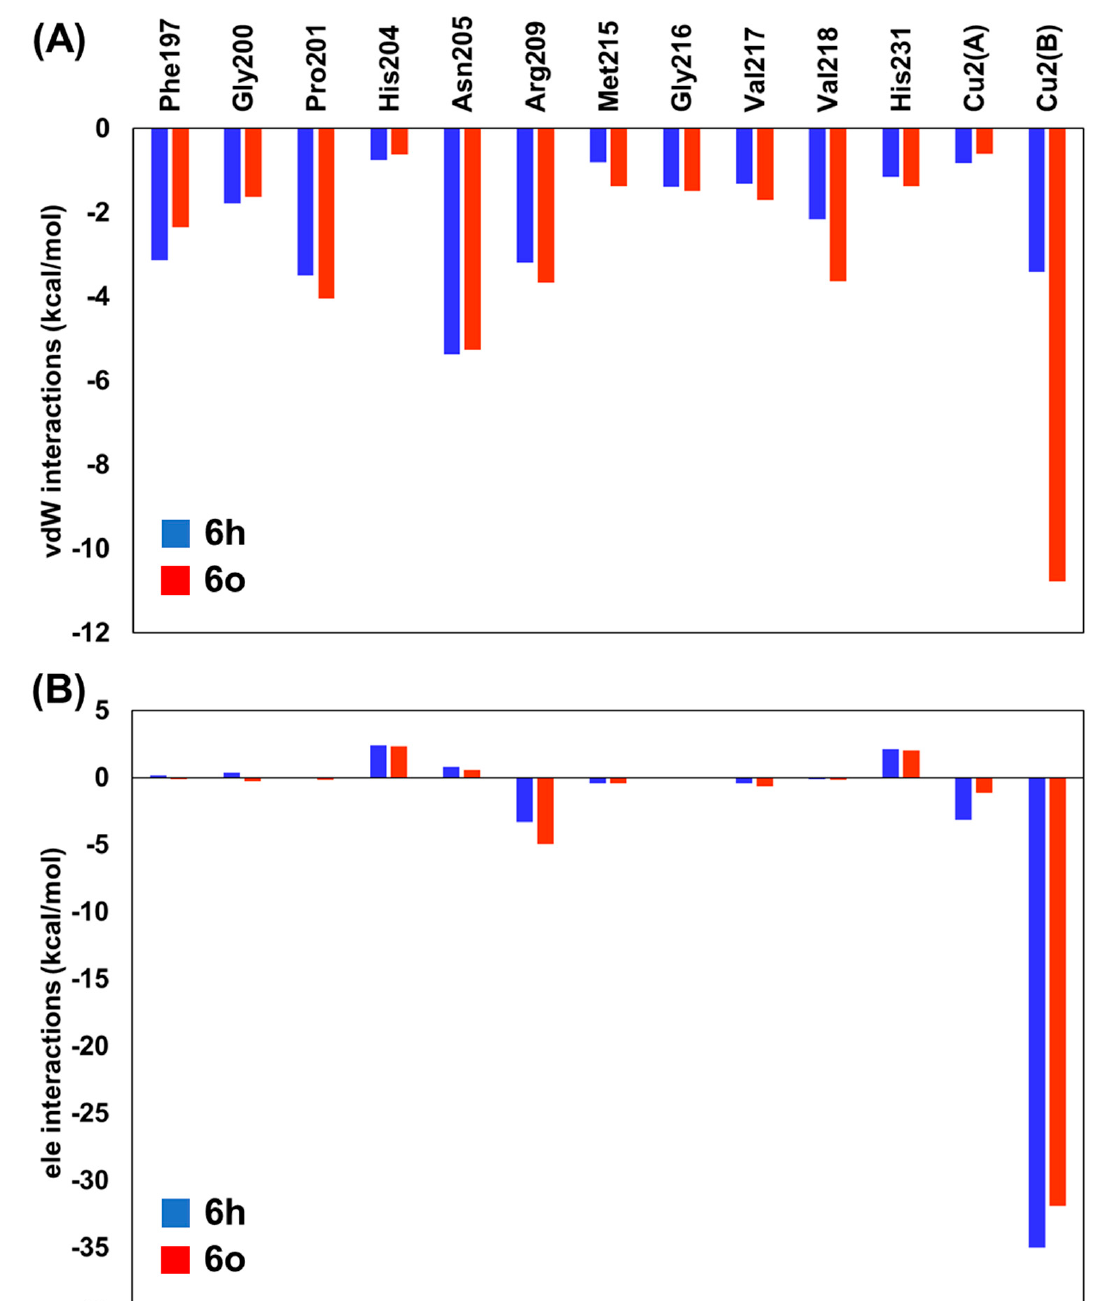
Figure 4. Residual interaction energies (in Kcal/mol) over 6h (blue) and 6o (orange) inhibitors used in the LIE calculations for the residues that contribute most to the ligand-surrounding ( A ) van der Waals ( vdW ) and ( B ) electrostatic ( ele ) contributions. The values for all TYR systems are provided as Supplementary Materials (Tables S2 and S3).